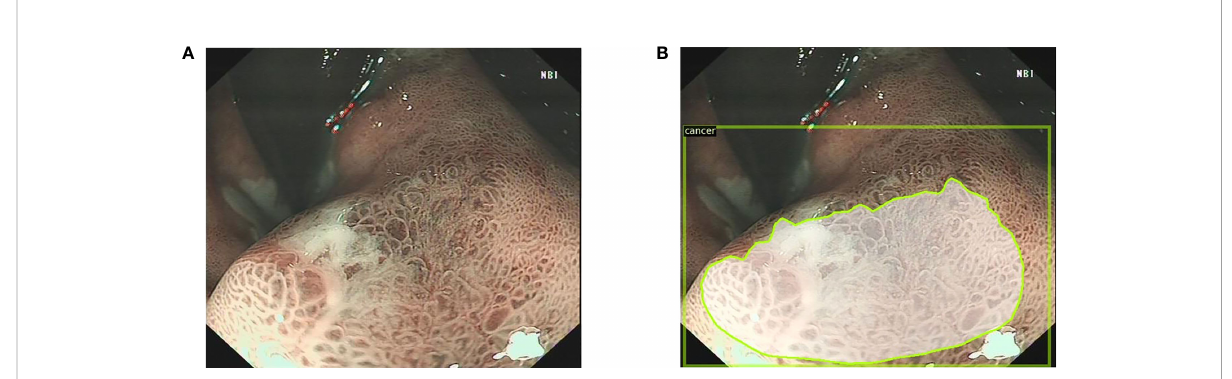
FIGURE 2 The endoscopists and the Mask R-CNN system delineate the lesion in narrow band images. (A) The narrow band image with the EGC lesion. (B) The Mask R-CNN system delineates the EGC lesion. Mask R-CNN, mask region-based convolutional neural network; EGC, early gastric